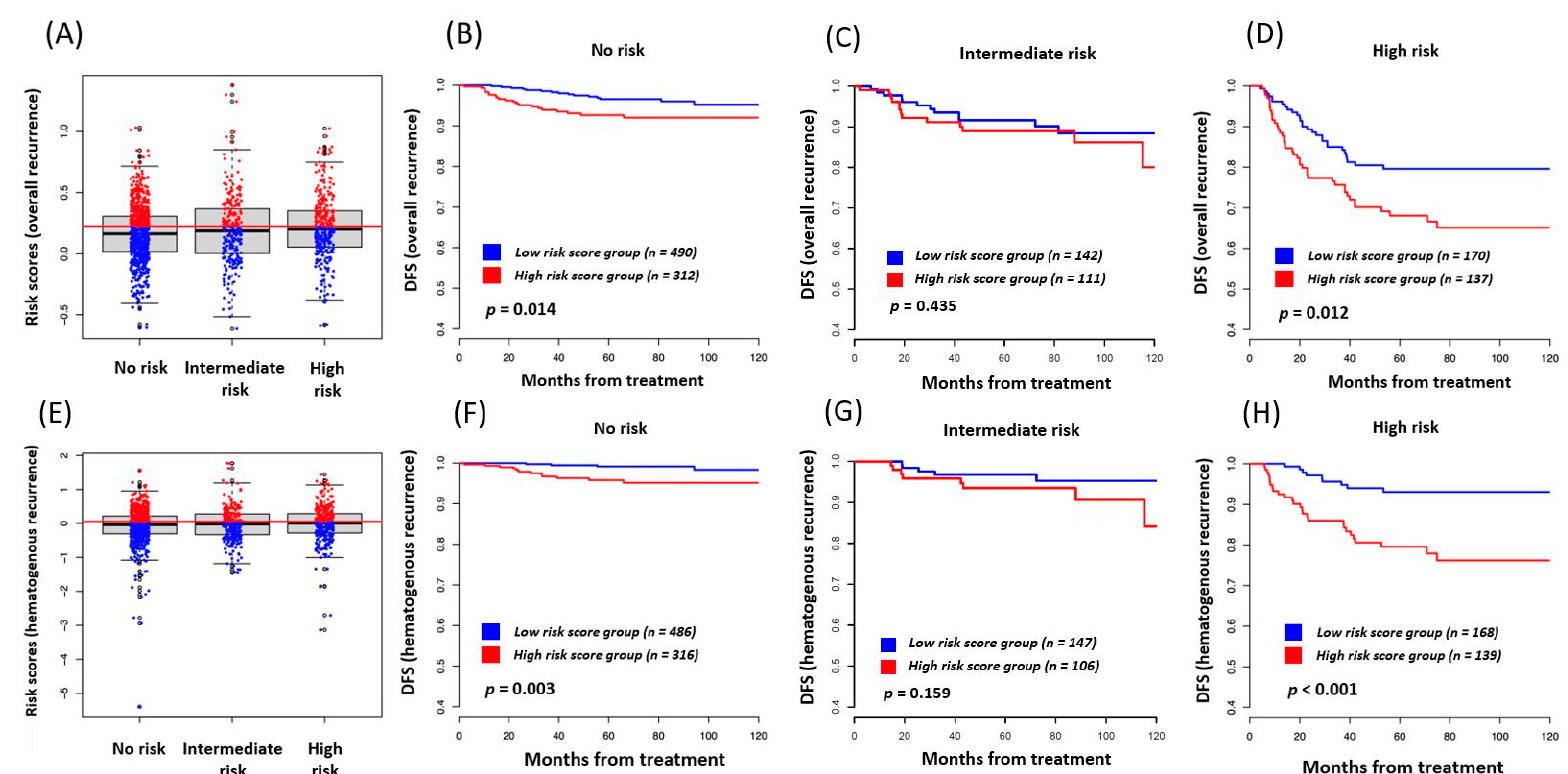
Figure 2. ( A ) Box-plots of risk scores calculated to predict DFS by the built model. Patients were classified according to the conventional risk factors as described in the text (no risk factors, intermediate risk factors, and high risk factors), ( B ) patients were divided into two groups in each classification according to their calculated risk scores. The Kaplan–Meier analysis of DFS of the patients with no risk factors is represented, ( C ) Kaplan–Meier analysis of DFS of the patients with intermediate risk factors is represented, (D) Kaplan–Meier analysis of DFS of the patients with high risk factors is represented, ( E – H ) the same analyses were performed to predict hematogenous recurrence, which also demonstrated similar patterns as the analyses for DFS.